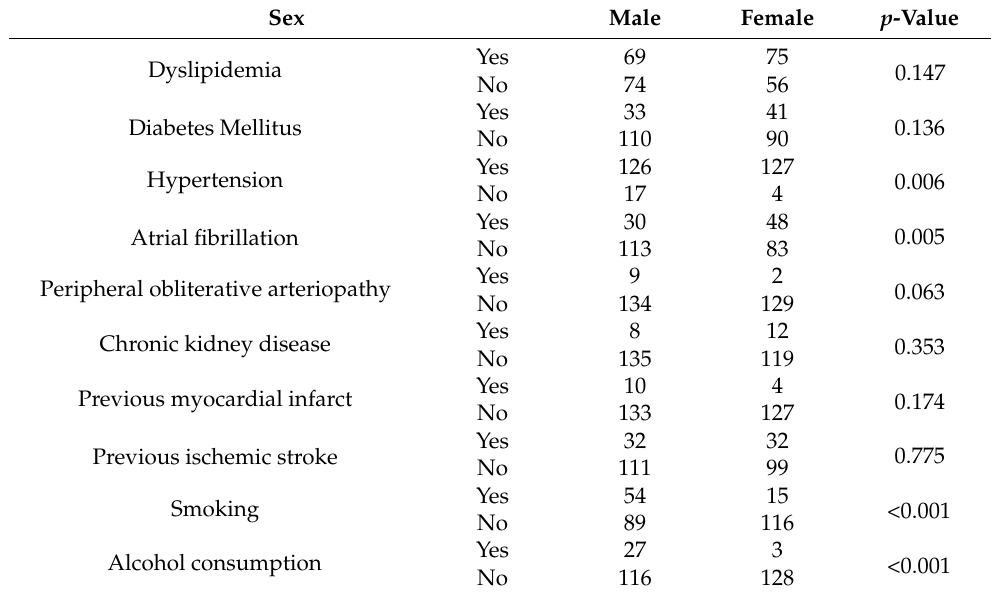
Table 3. Crosstabs between sex and risk